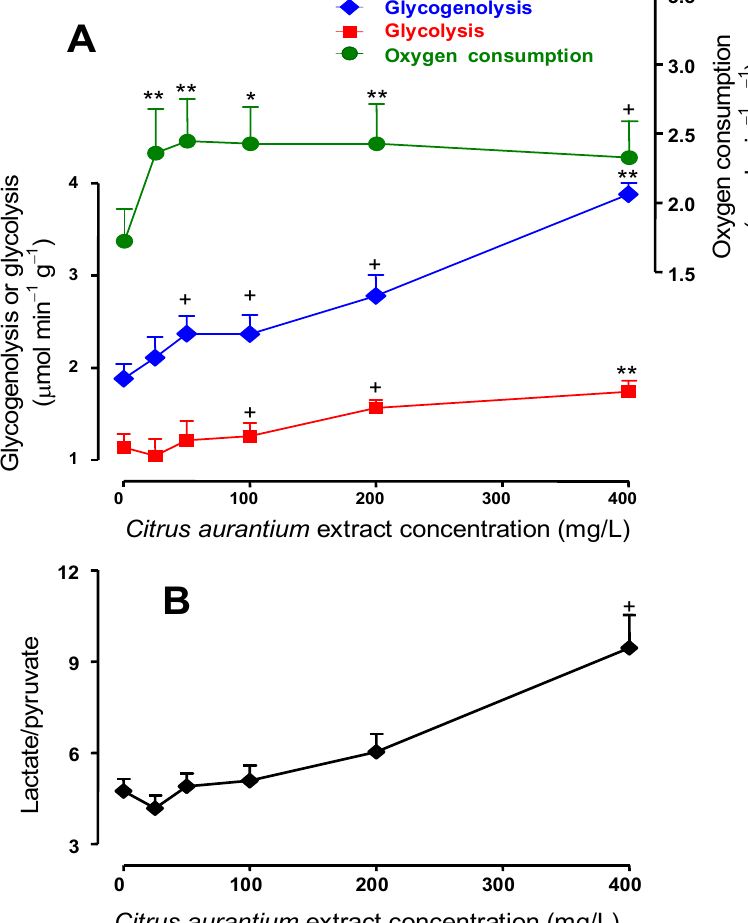
Figure 3. Concentration dependences of the effects of the C. aurantium extract on glycogen catabolism and endogenous fatty acids-driven oxygen uptake. Data were obtained from experiments of the kind illustrated by Figure 2. Glycogenolysis and glycolysis are expressed as glucosyl units and were calculated as glucose production +½(lactate production + pyruvate production) and lactate production + pyruvate production, respectively. Each datum point represents the mean of three liver perfusion